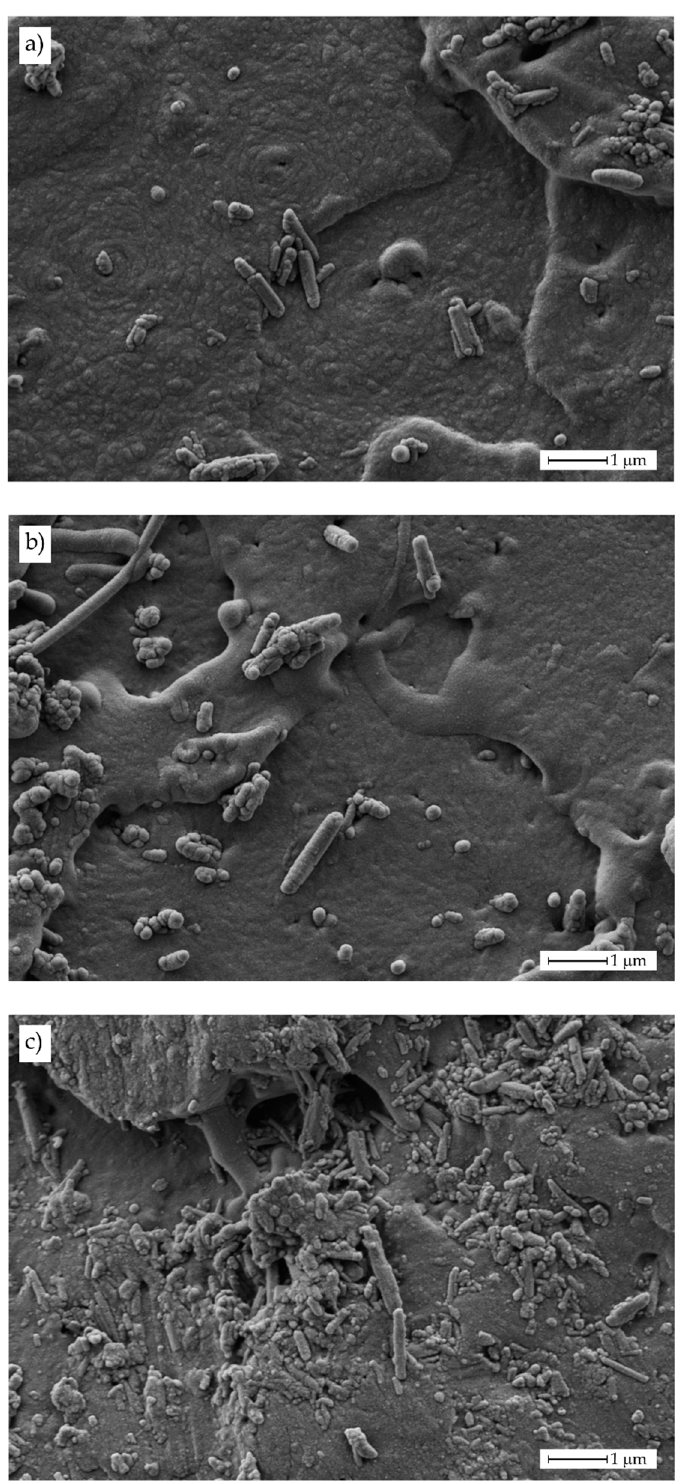
Figure 4. Field emission scanning electron microscopy (FESEM) images at 10,000 × of fractured samples from impact tests corresponding to PLA-HNT composites with different HNTs loading. ( a ) 3 wt% HNTs, ( b ) 6 wt% HNTs and ( c ) 9 wt% HNTs.